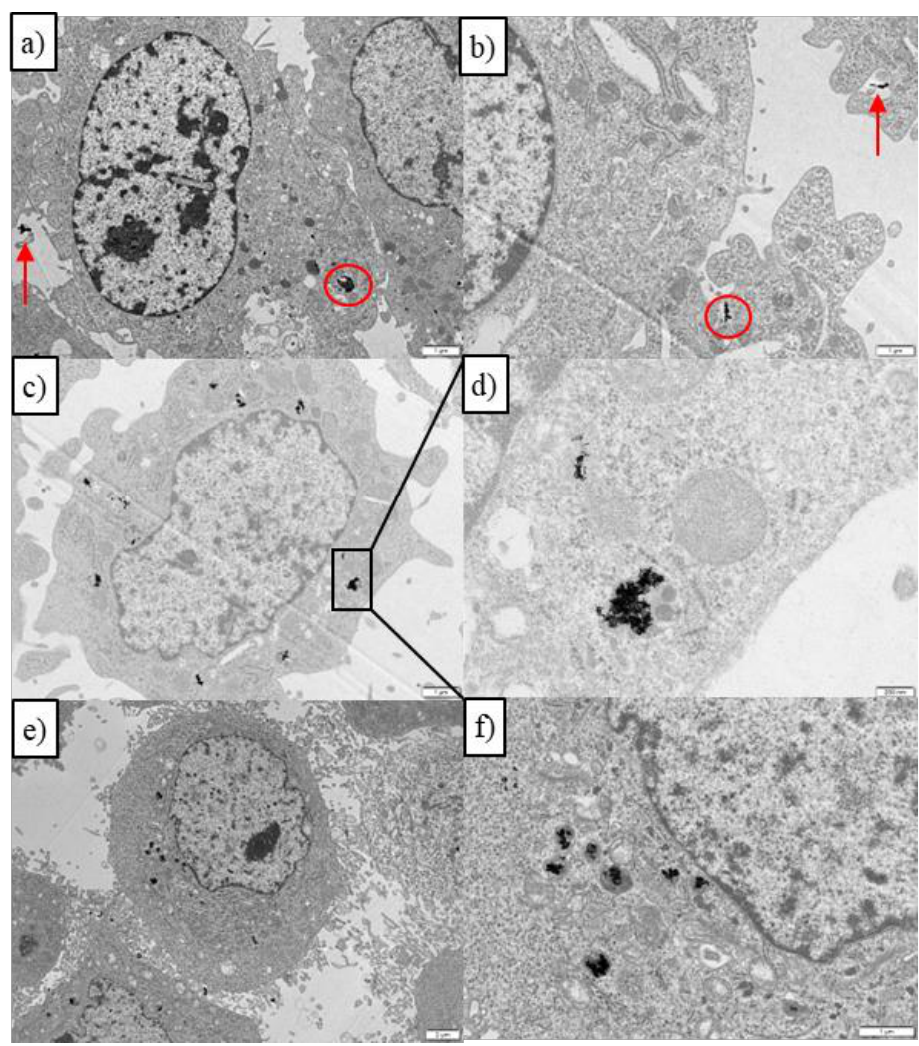
Figure 5. TEM images of PSS/DOXO/PLL/HA-coated AuNRs inside ( a , b ) 3T3 Balb in the absence of NIR illumination, and HeLa cells ( c , d ) in the absence and ( e , f ) presence of NIR illumination (808 nm, 1.0 W/cm 2 for 5 min). ( d ) depicts a zoomed endocytic vesicle containing numerous AuNRs. In ( a , b ), red circles denote particles inside cells endosomes. Red arrows denote particles in the surroundings of the cell membrane. Scale bars are 1 m.